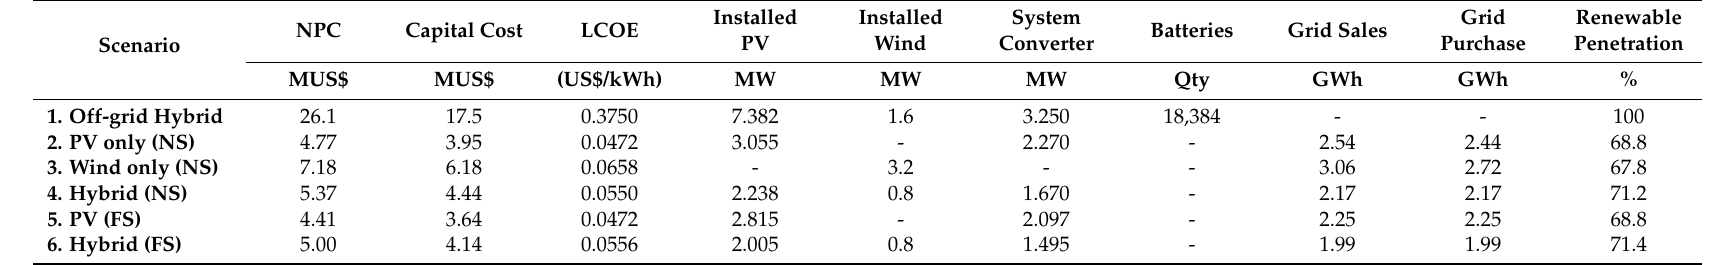
Table 4. Comparison of six scenarios of renewable energy